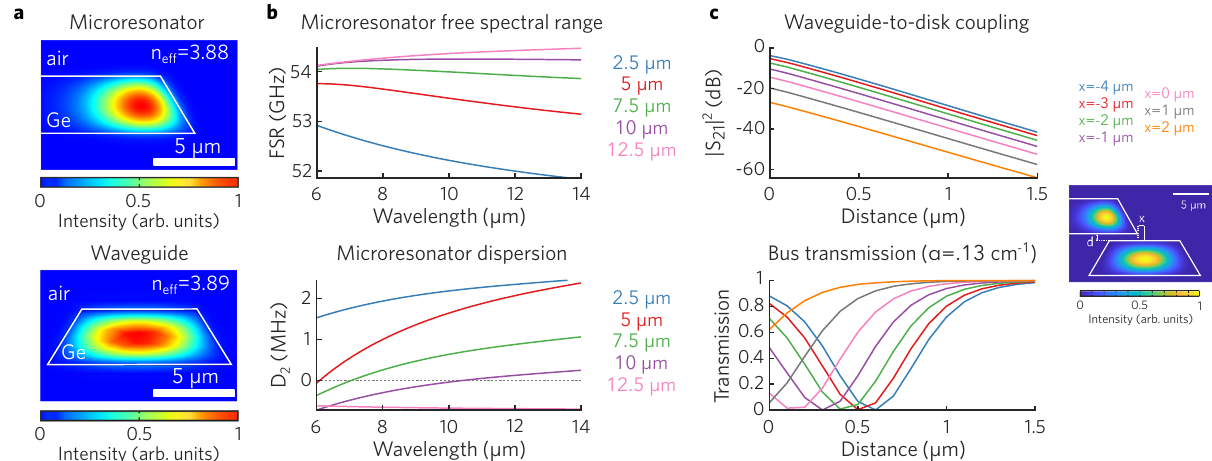
Fig.2|Simulationsofmode,dispersionandcouplingprocess.a FEMsimulation of the guided quasi-TE mode in the Ge WGM microresonator from Fig. 1a and Ge waveguide from Fig. 1c. b Calculated free spectral range and dispersion versus waveguidethicknessfora450 μ mdiameterwaveguide.Lowanomalousdispersion (positive D 2 ) isonly possiblewith very thick waveguides, in the 7.5 – 10 μ m rangeat